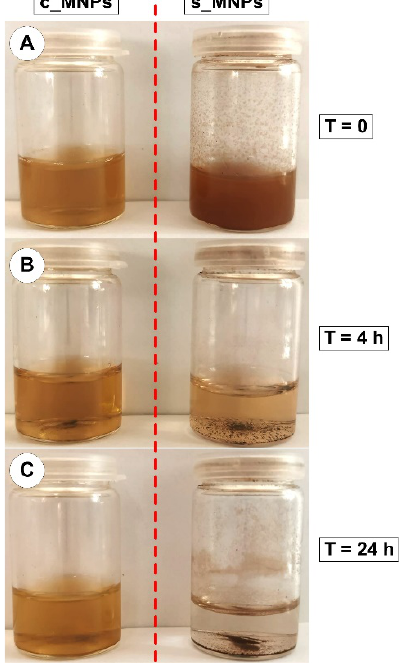
Figure 14. Sedimentation as a function of time for the PEG-coated IONPs suspensions.